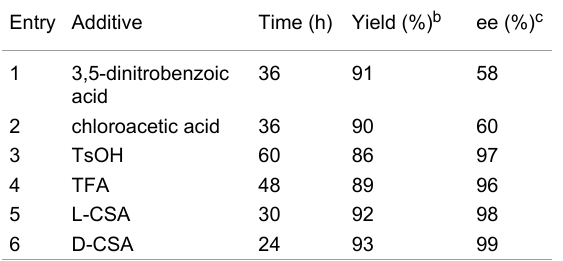
Table 3: Additive screening of the 1a catalyzed Michael addition of acetone ( 2a ) to isatylidenemalononitrile ( 3a ) a . Entry